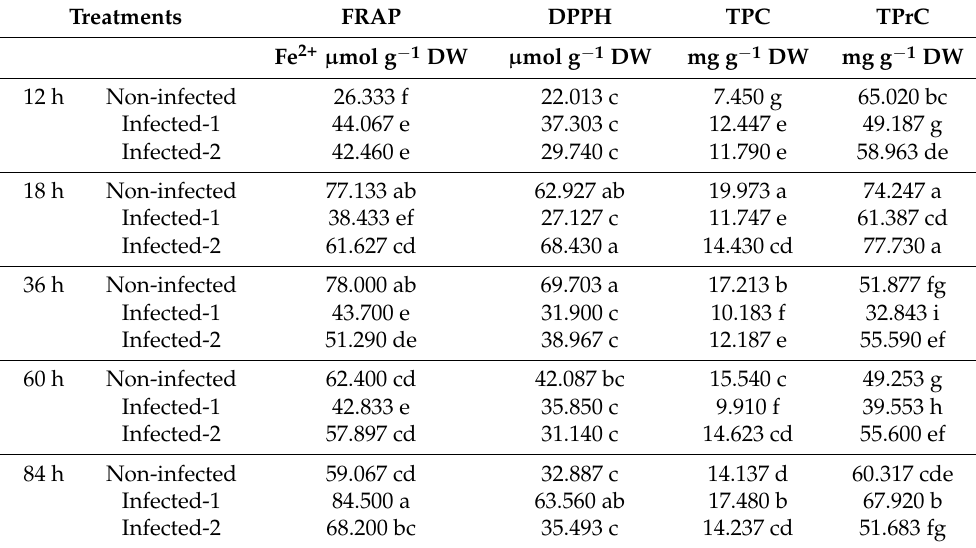
Table 5. Biochemical measurements of “Little Gem” lettuce after 12, 18, 36, 60, and 84 h of artificial infection.